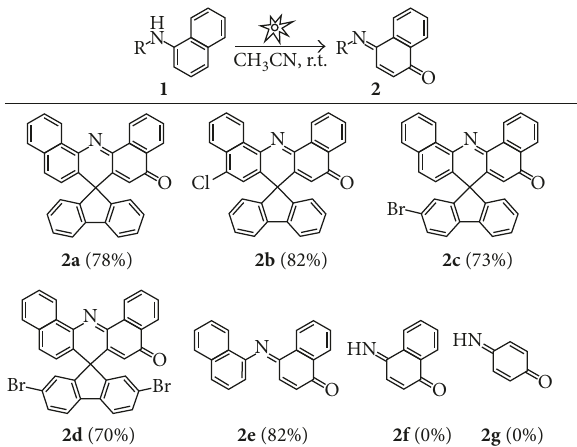
Scheme 2: Scope of the iminoquinones. a Reactions were carried out with 1 (2.0 mmol) in MeCN (400 mL) for 6h. b Isolated yields